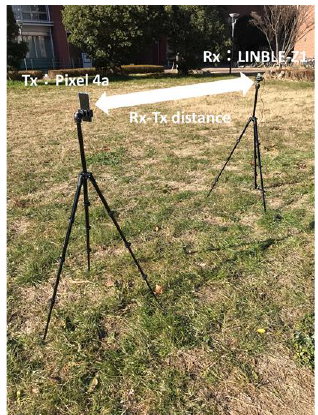
Figure 11. View of Pixel 4a for Tx and LINBLE-Z1 for Rx.